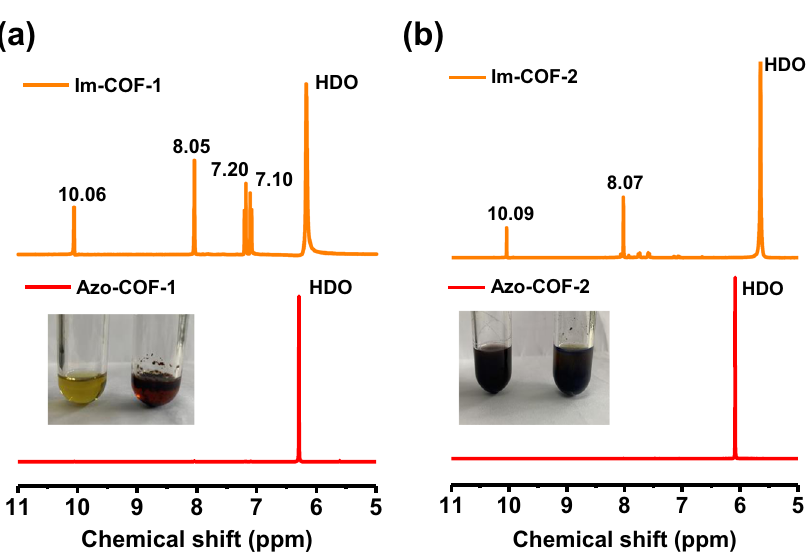
Fig. 4 Results of the hydrolysis experiments. 1 H NMR spectra of ( a ) Im-COF-1 and Azo-COF-1, and ( b ) Im-COF-2 and Azo-COF-2 after being treated with DCl in DMSO- d 6 . Insets: photographs of the samples after acid treatment. a Left: Im-COF-1. Right: Azo-COF-1. b Left: Im-COF-2. Right: Azo-COF-2.